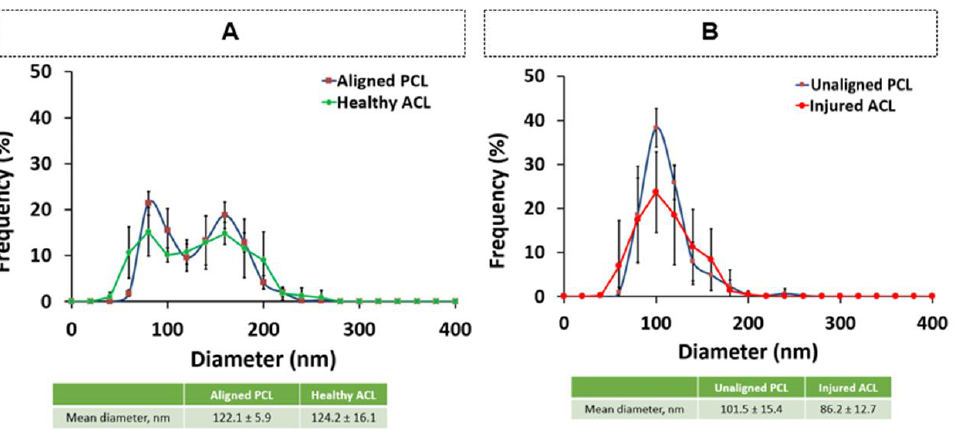
Figure 6. Comparison of diameter distributions of ( A ) aligned PCL vs. healthy ACL and ( B ) unaligned PCL vs. injured ACL. No significant difference was detected for either comparison at p < 0.05.